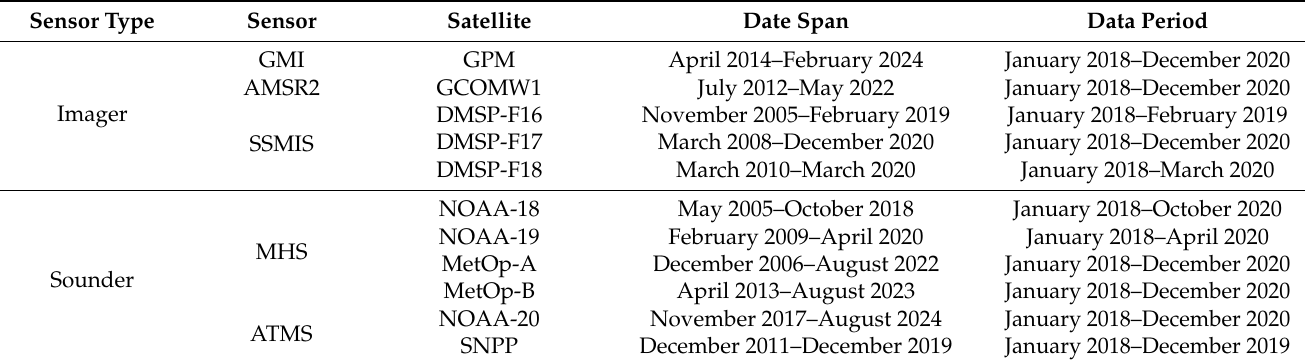
Table 1. Input sources of passive microwave sensors for IMERG precipitation during 2018–2020.